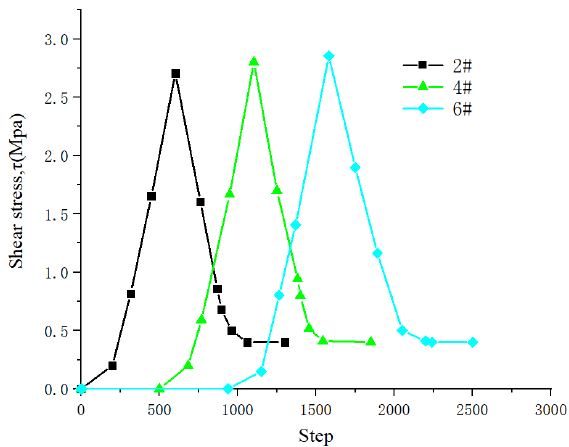
Figure 12. Shear stress evolution process of measuring point.